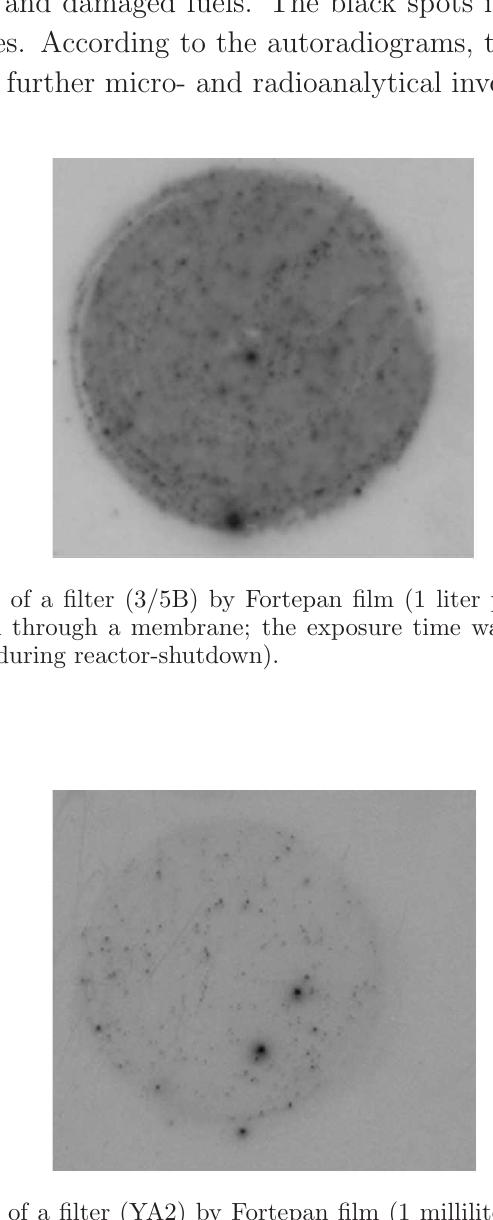
Fig. 4 Autoradiogram of a filter (YA2) by Fortepan film (1 milliliter water of the reactor was filtered through the filter; the exposure time was 70 hours; the samples were collected after the cleaning tank incident on April 17,